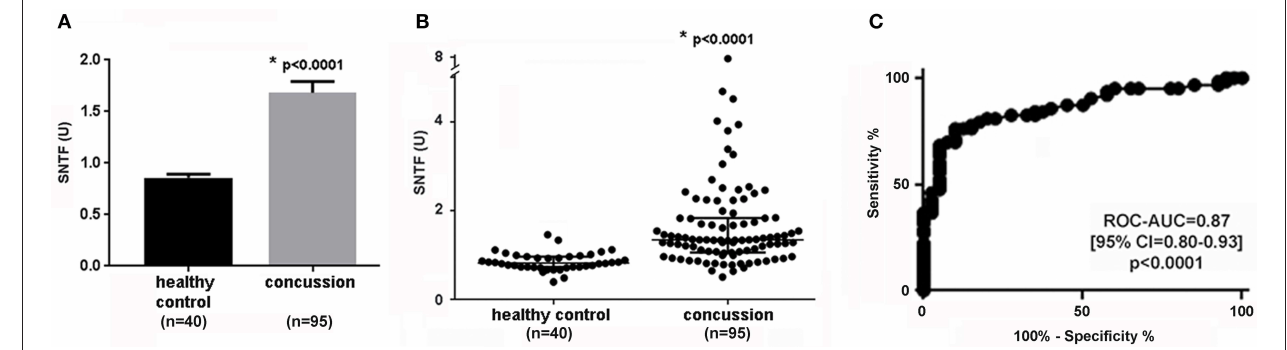
FIGURE 2 | Serum SNTF is significantly elevated on the day of mTBI and is diagnostic for a subset of the injuries. Between group comparisons and ROC-AUC analyses were evaluated by Mann-Whitney U test. Each study participant was evaluated for serum SNTF a minimum of 4 times. (A) In group analysis, mean serum SNTF levels on the day of mTBI are 92% higher than their mean levels in healthy controls. The bars represent the S.E.M. Between group statistical comparison by two-tailed t -test. (B) In group analysis, median serum SNTF levels on the day of mTBI are 63% higher than their median levels in healthy controls. The filled circles represent each case, and the bars represent quartiles. Note that whereas some of the mTBI cases have serum SNTF levels indistinguishable from the range of the controls, a subset have SNTF levels markedly elevated over the entire control group. Between group statistical comparison by Mann-Whitney U -test. (C) In ROC-AUC curve analysis, serum SNTF levels on the day of mTBI distinguish a subset of injured patients from healthy controls. At a cutoff value of 1.54U, serum SNTF is 100% specific and 37% sensitive for mTBI. The AUC is 0.87, the 95% confidence interval is 0.80–0.93, and is significantly different from chance ( p < 0.0001; Mann-Whitney U